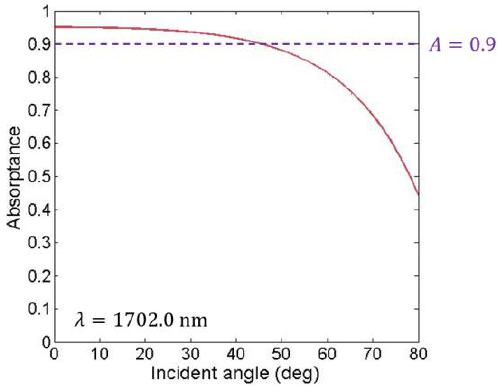
Figure 7. Absorptance of the designed 1-D PCCH [(EF) 2 D] 6 as a function of the incident angle at the short-wavelength angle-insensitive band edge 𝜆 = 1702.0 nm under TM polarization. short-wavelength angle-insensitive band edge λ = 1702.0 nm under TM